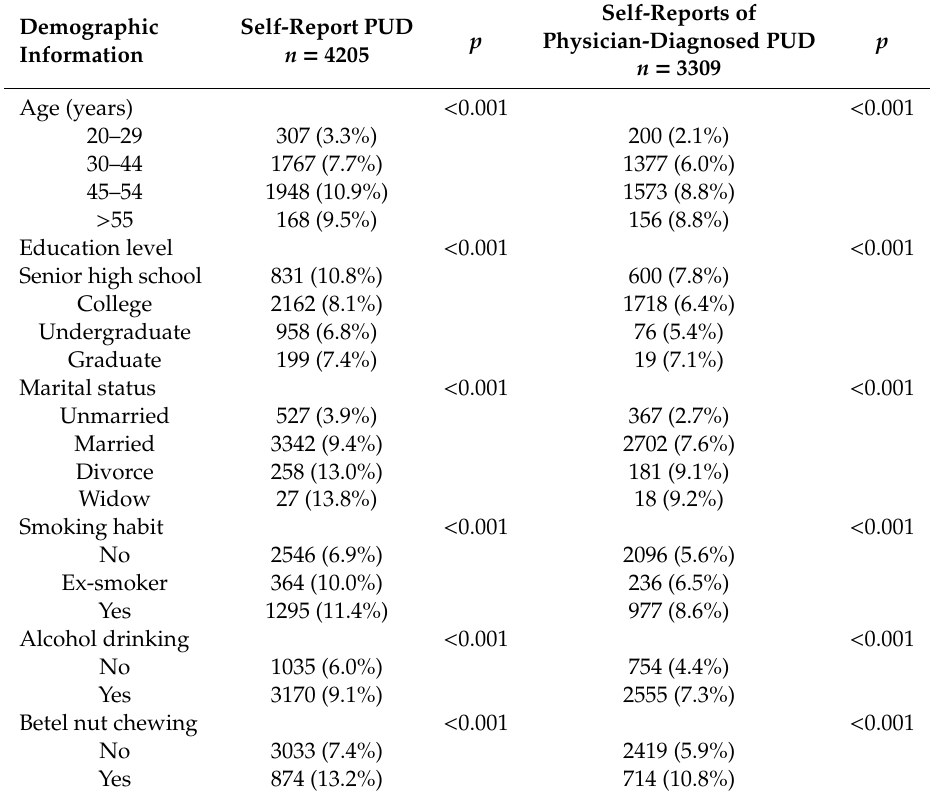
Table 1. Demographic information by self-reported and self-reports of physician-diagnosed peptic ulcer disease (PUD).